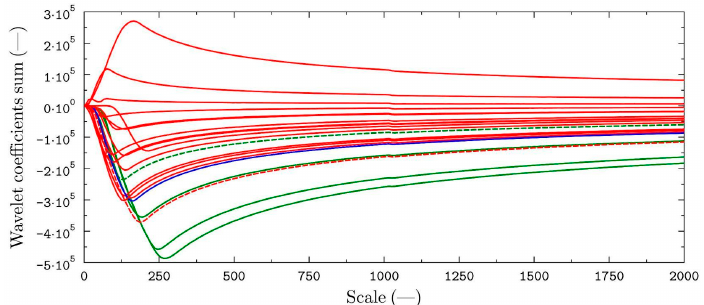
Figure 7. Curves representing sums of wavelet coefficients. Each curve was obtained as a result of summing up wavelet coefficients after the application of the continuous wavelet transform of pH signals for a selected patient during 24 h of measurement procedure. Different colours indicate marginal cases of calculated DeMeester score: blue line—base line (DeMeester 15.9); red—a patient diagnosed with reflux (DeMeester > 15.9); green lines—healthy patient (DeMeester < 15.9); black dashed line—misclassified patients.